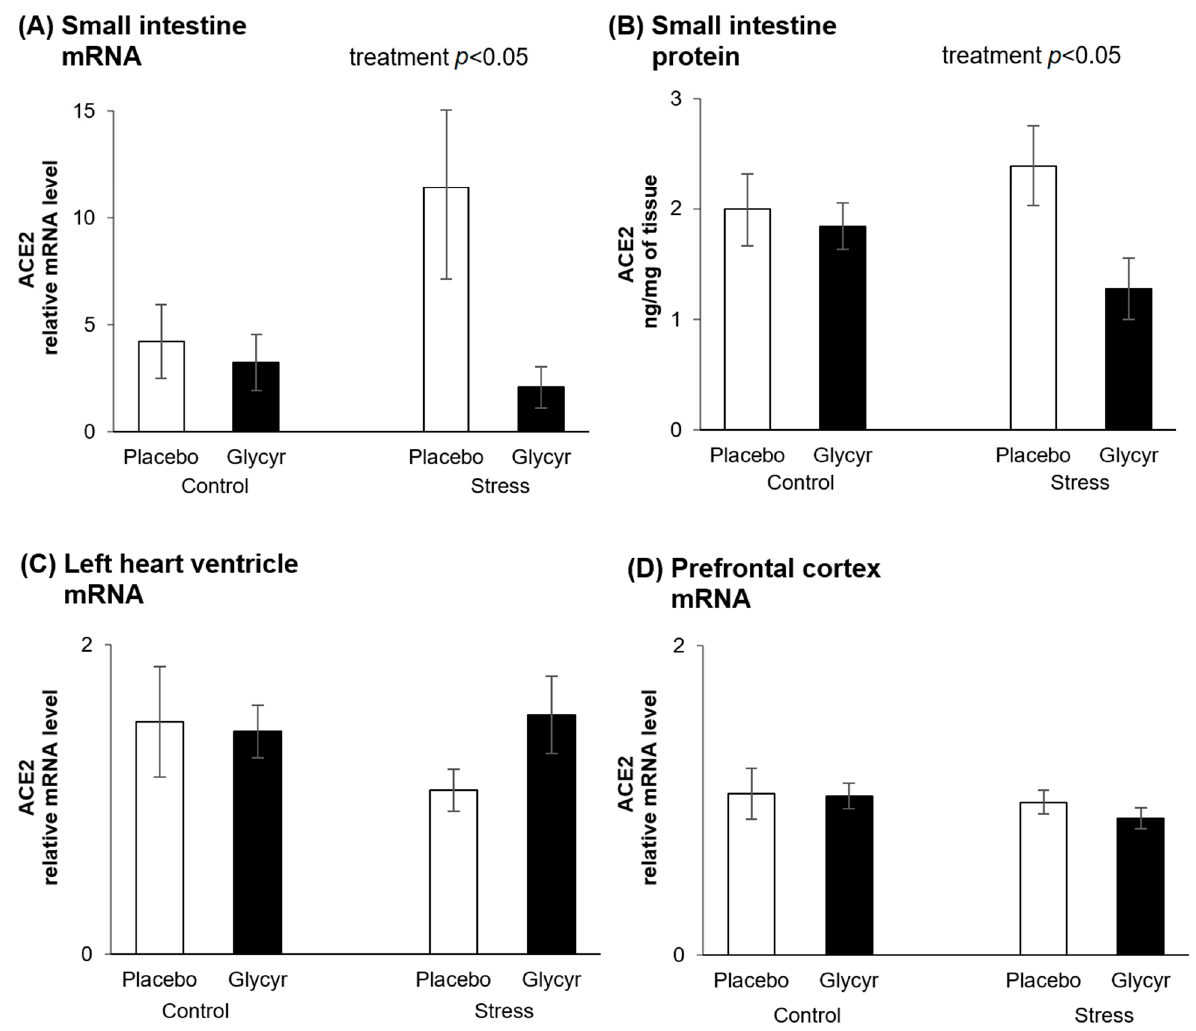
Figure 1. ACE2 gene expression in the small intestine ( A ), ACE2 protein expression in the small intestine ( B ), ACE2 gene expression in the left heart ventricle ( C ) and ACE2 gene expression in the prefrontal cortex ( D ) of rats treated with Glycyrrhiza glabra extract or placebo with or without exposure to chronic mild stress. Each value represents mean ± standard error of the mean (SEM) ( n = 12 rats/group). Statistical significance as revealed by two-way